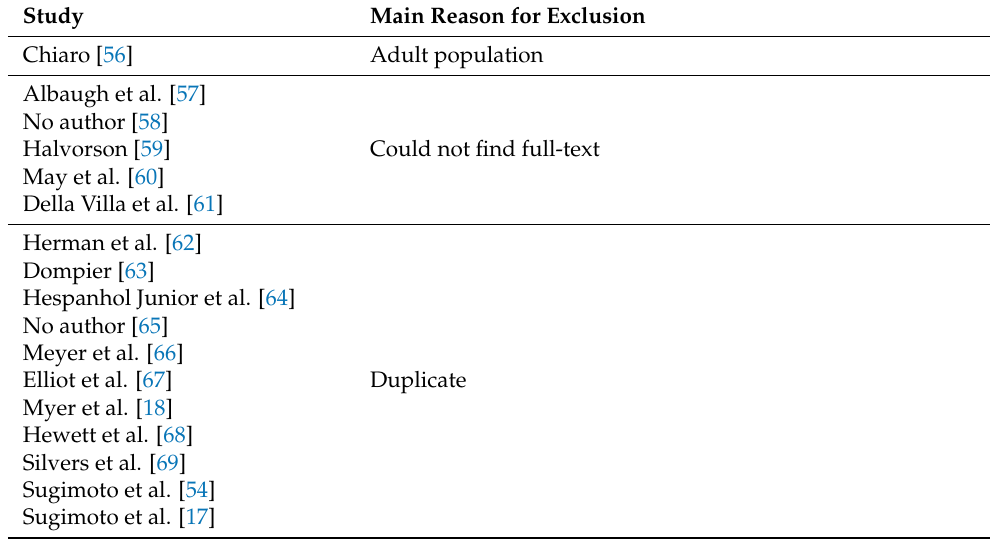
Table A1. The reasons for the exclusion of all studies that were excluded after a full-text review are listed